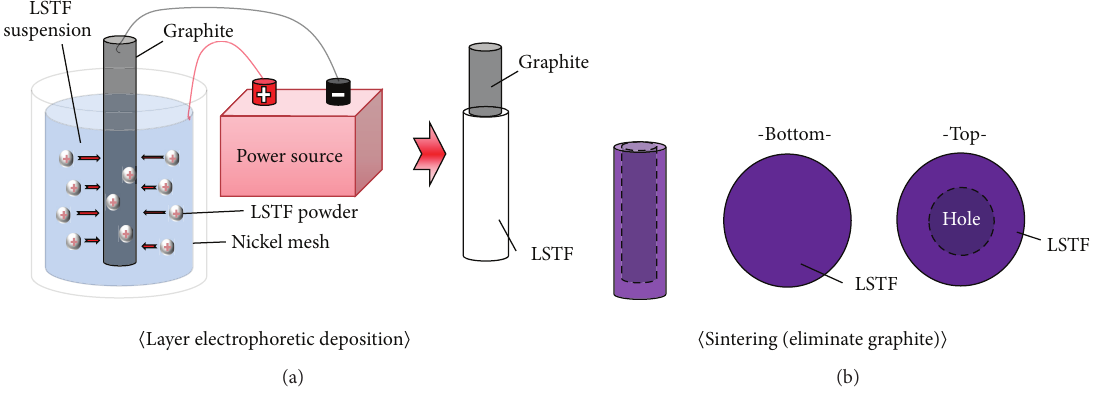
Figure 1: Schematic diagram of the (a) EPD process and (b) sintering